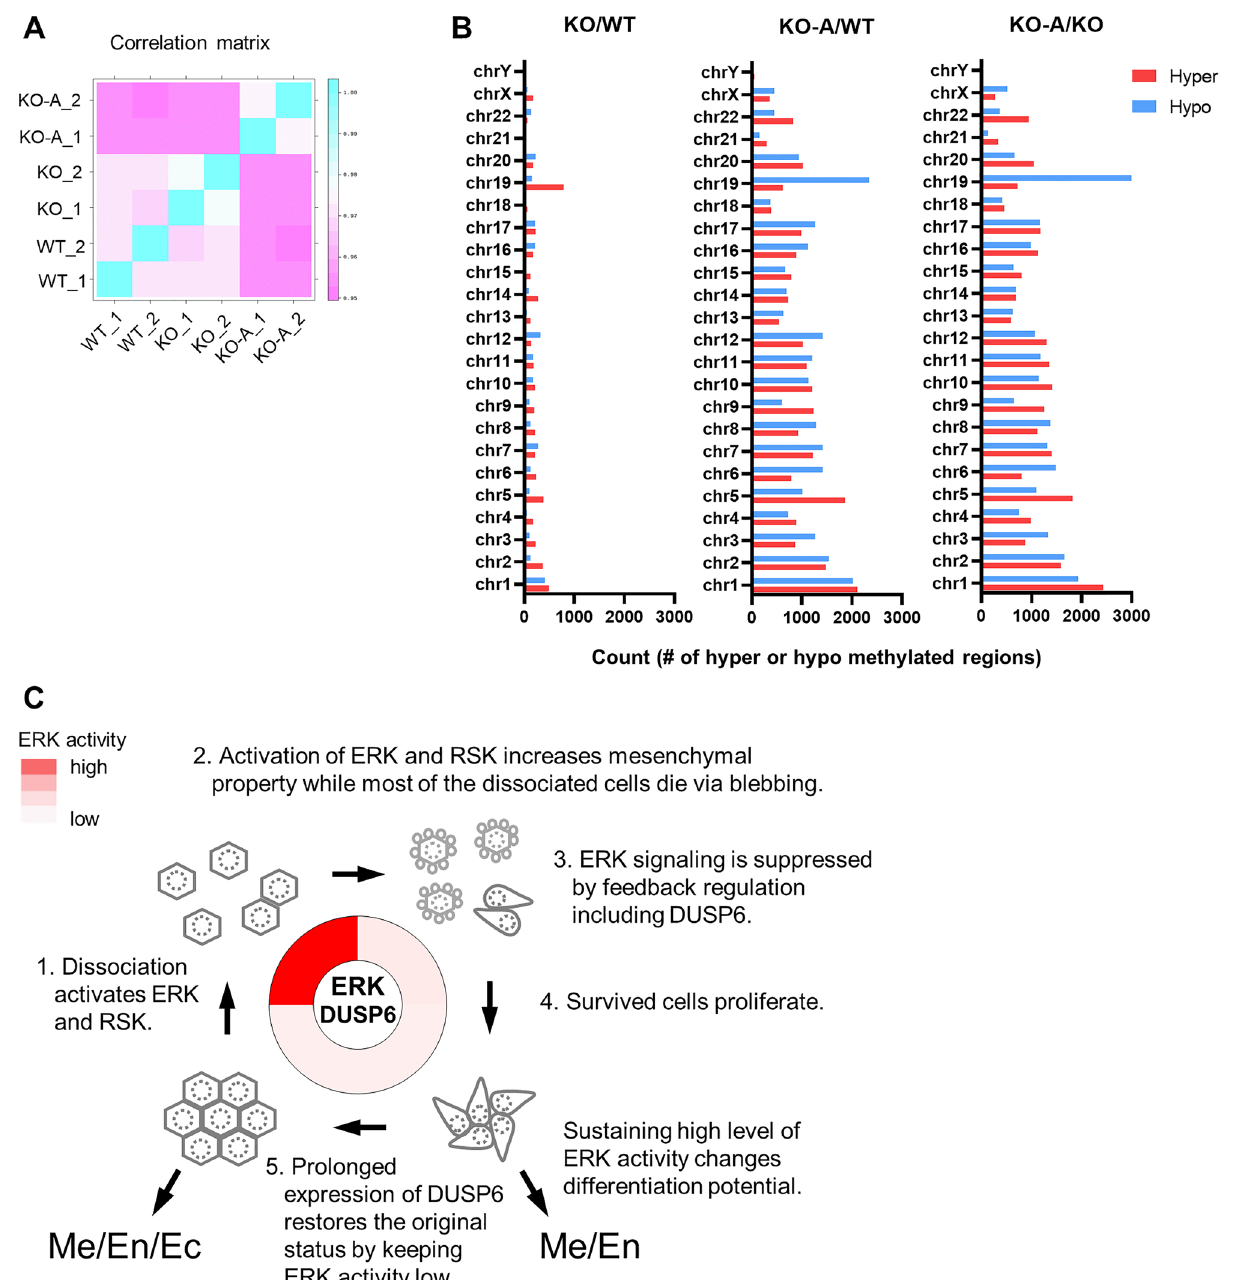
Figure 6. DNA methylation in DUSP6 KO cells and modeling of cellular resilience. ( A ) Correlation matrix analysis of WT, KO, and KO-A. Samples were duplicated for analysis. ( B ) Comparison of hyper-methylated (red) or hypo-methylated (blue) regions between samples. ( C ) Proposed model of cellular resilience by ERK and DUSP6 feedback loop in response to cell dissociation in hPSCs. Well-formed cell–cell and cell–matrix connections maintain epithelial characteristics of hPSCs with a balanced differentiation propensity. Dissociation activates ERK and RSK, which increases mesenchymal property. Increased mesenchymal property may increase survival rate although most dissociated cells die. Survived cells proliferate and suppress ERK activity by prolonged expression of DUSP6. Without the suppression, cells sustaining high level of ERK activity changes differentiation potential. Me mesoderm, En endoderm, Ec